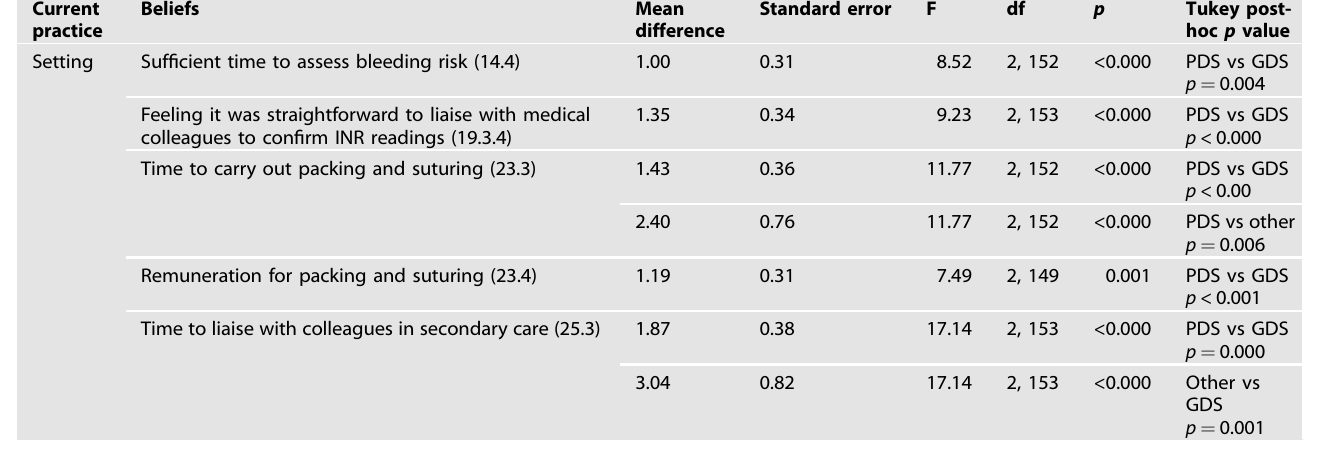
Remuneration for packing and suturing